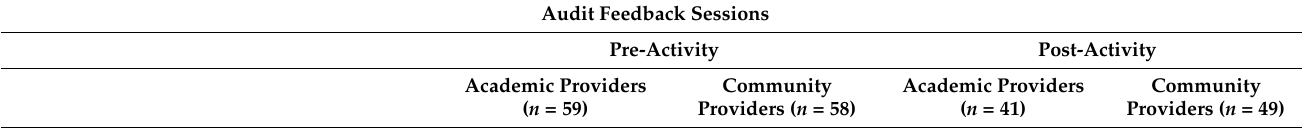
Table 5. Audit Feedback